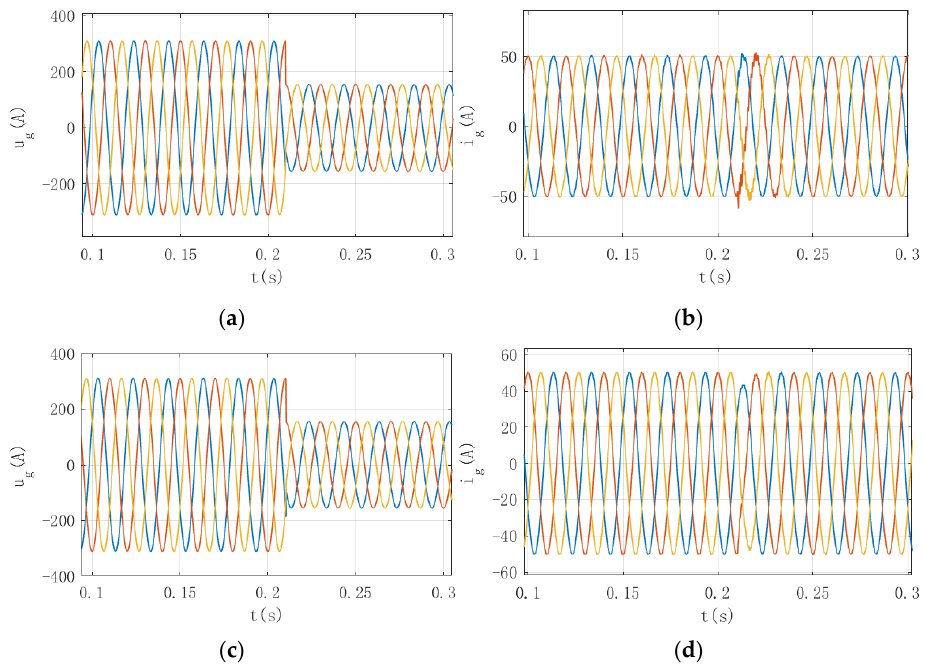
Figure 9. Grid voltage and grid current when grid voltage drops under PI control and LADRC control. ( a ) Grid voltage with PI control; ( b ) grid current with PI control;( c ) grid voltage with ADRC control; ( d ) grid current with ADRC control.